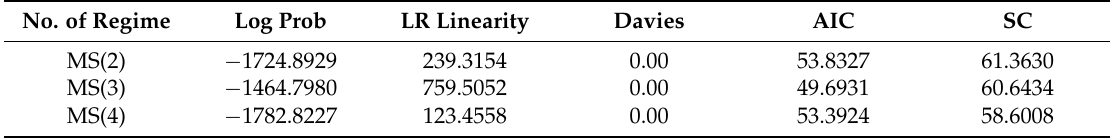
Table 5. Test statistics and regime determinants for VAR(2)